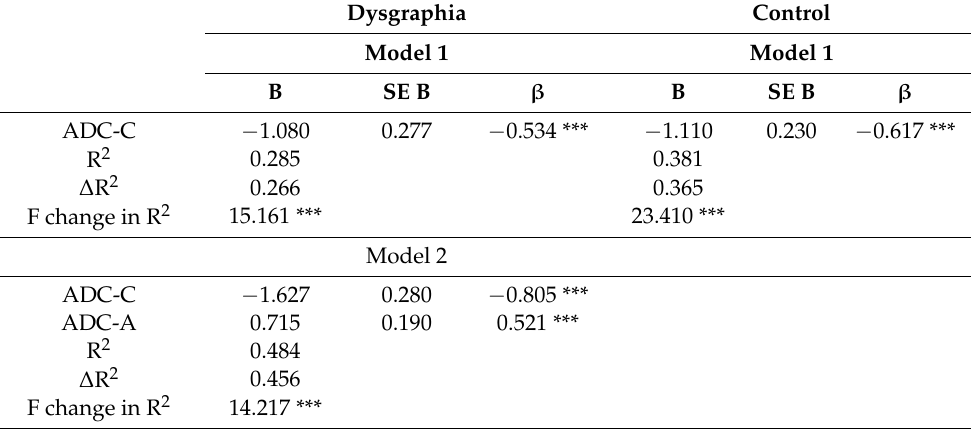
Table 8. Prediction of physical QOL by the ADC subscales among adolescents with dysgraphia and the control group.